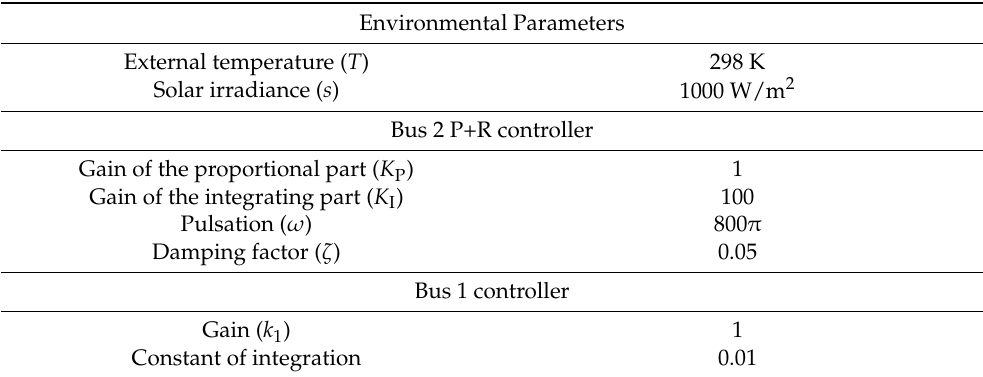
Table 2. Summary of the environmental and control parameters used in the test.